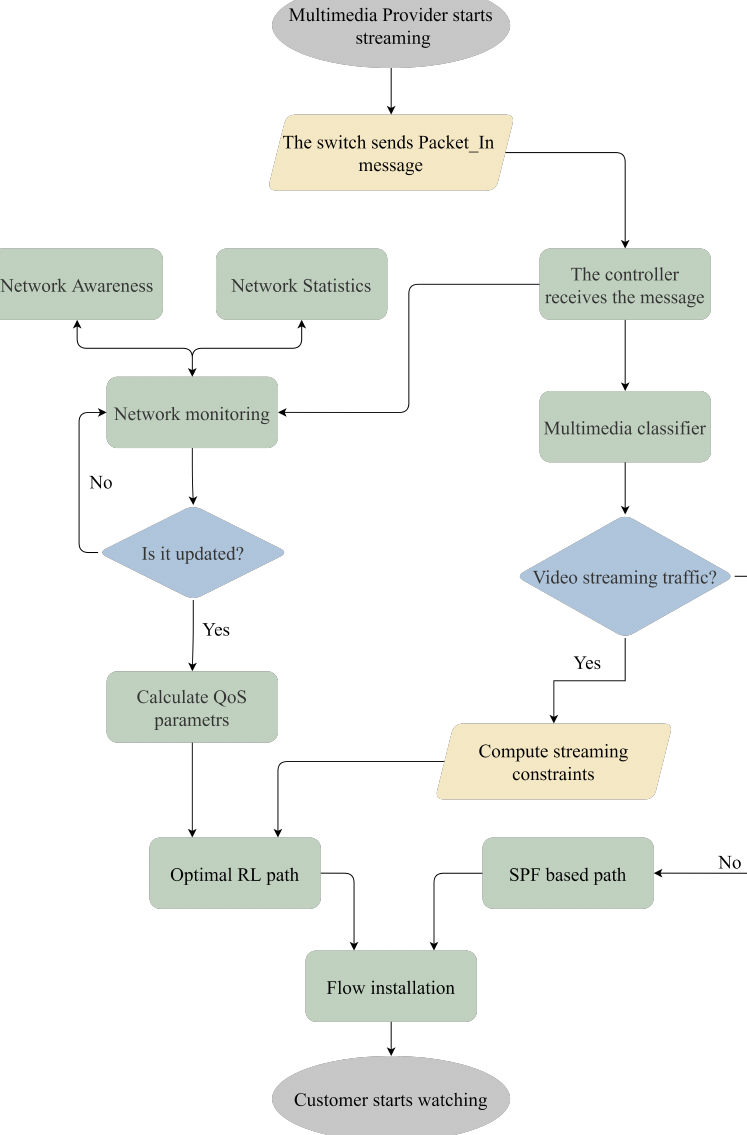
Figure 2. Flowchart of the proposed RL-based multimedia traffic